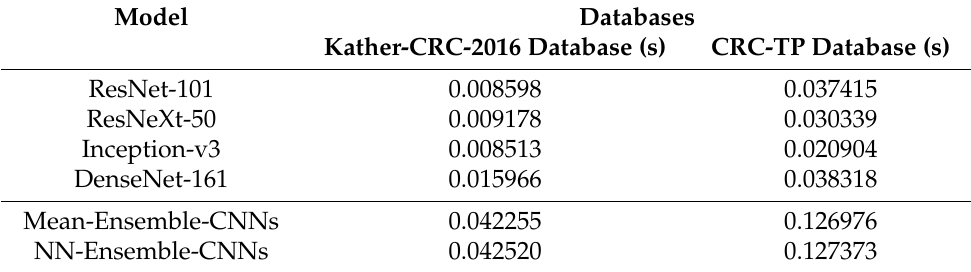
Table 6. Testing time for the evaluated CNN architectures (ResNet-101, ResNeXt-50, Inception-v3 and DenseNet-16) and our proposed approaches (Mean-Ensemble-CNNs and NN-Ensemble-CNNs) for each